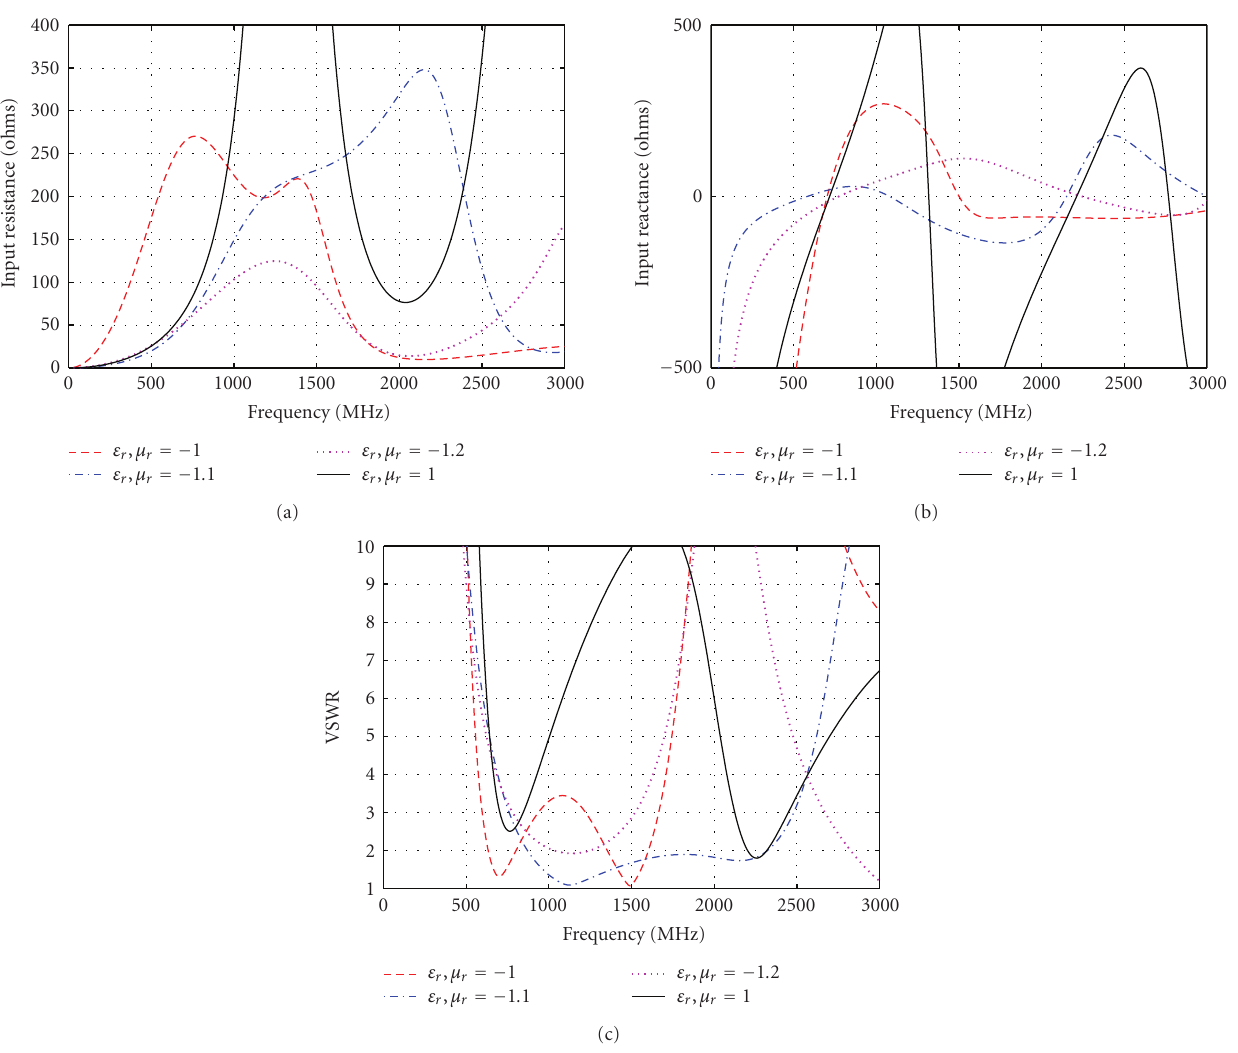
Figure 7: (a) Input resistance; (b) reactance, and (c) VSWR. Other parameters: L = 200 mm, a = 0 . 3175 mm, b = 1 . 8542 mm, r = 0 . 3175 mm, and N =